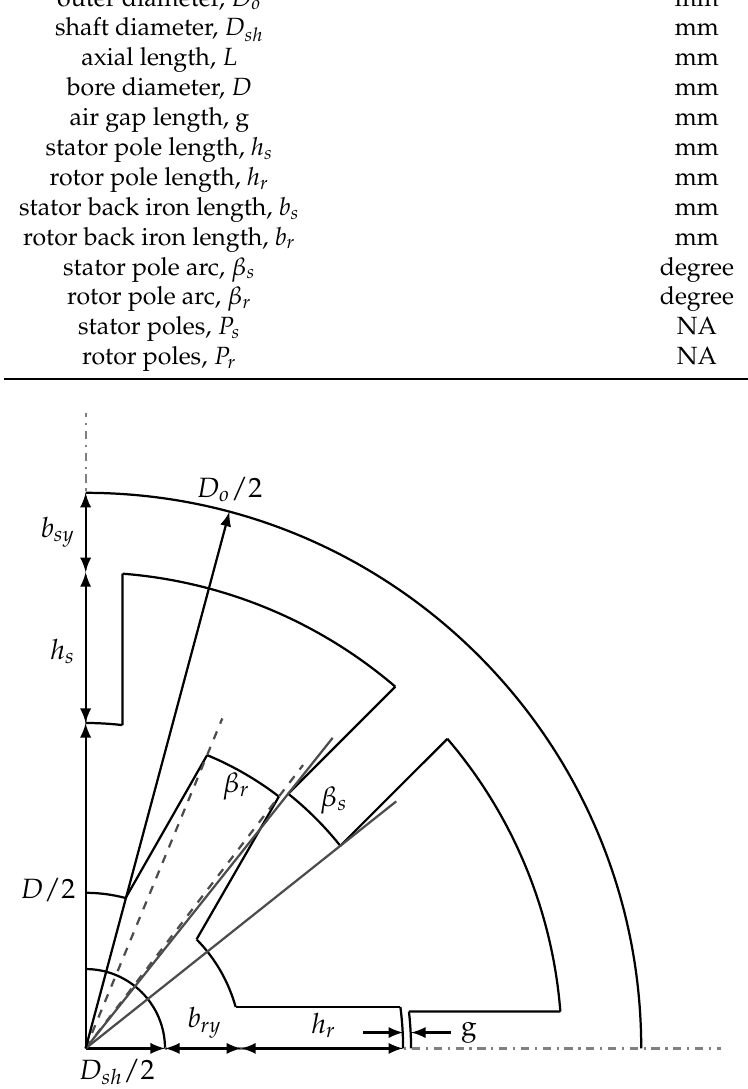
Figure 2. Lamination dimensions considered in optimization